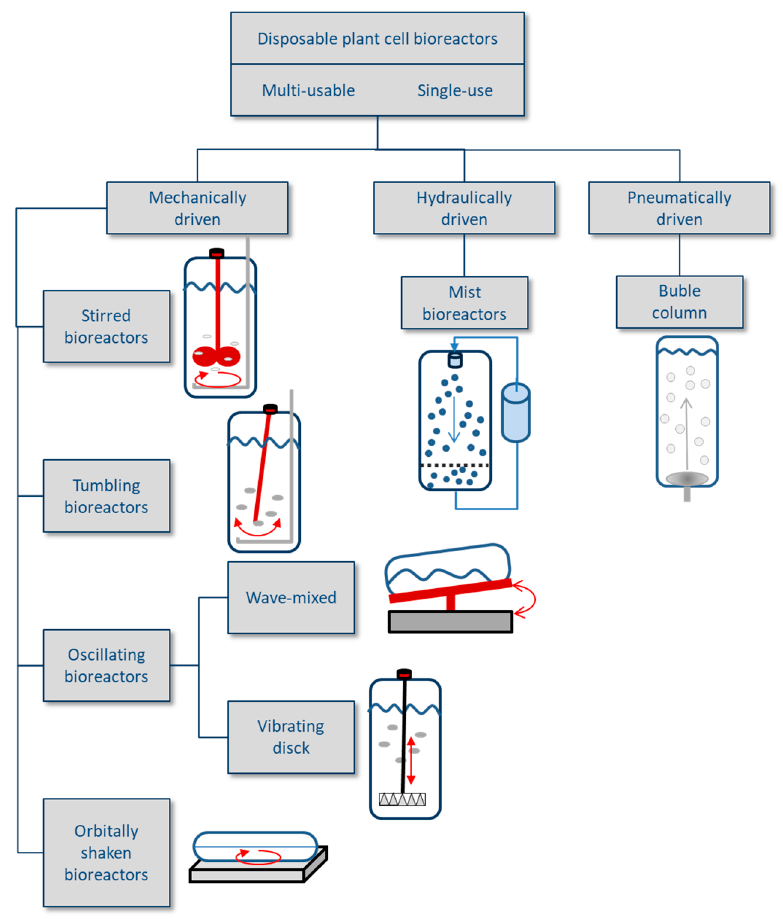
Figure 6. Disposable bioreactors classified according to their driving system (modified from Lehmann et al.